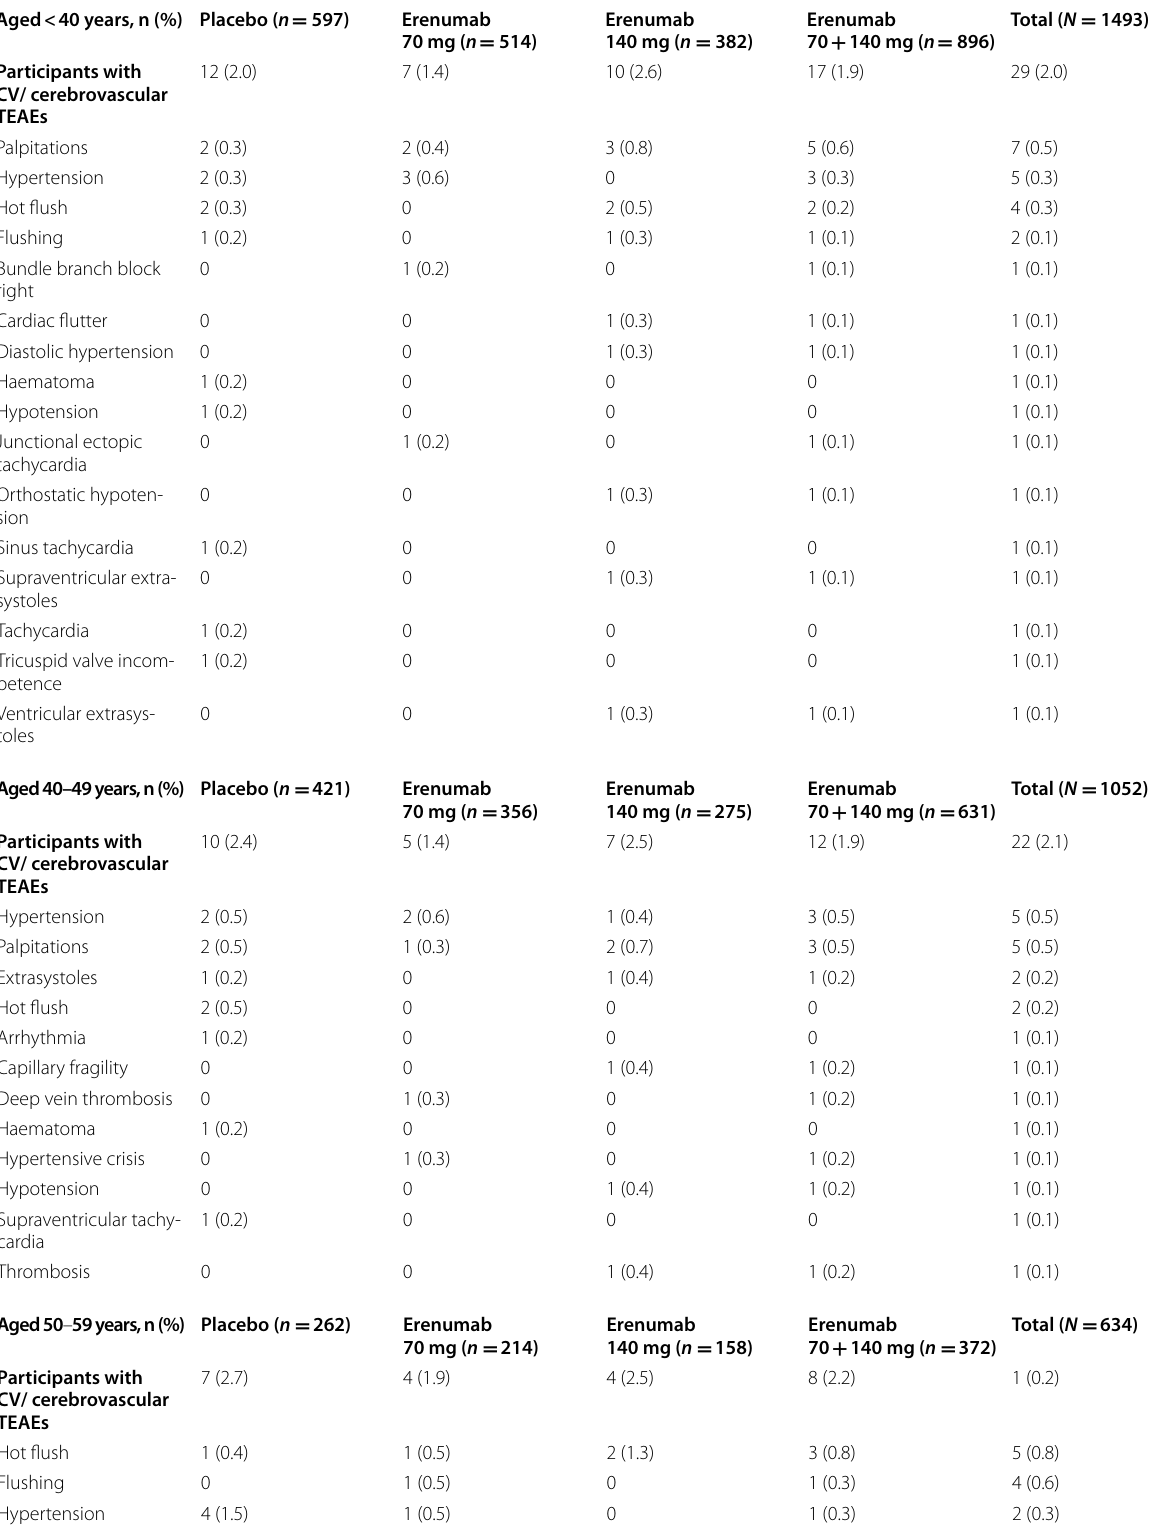
Table 6 Summary of cardiovascular and cerebrovascular AEs by age groups (safety analysis set) by preferred term Aged < 40 years, n (%) Placebo ( n =